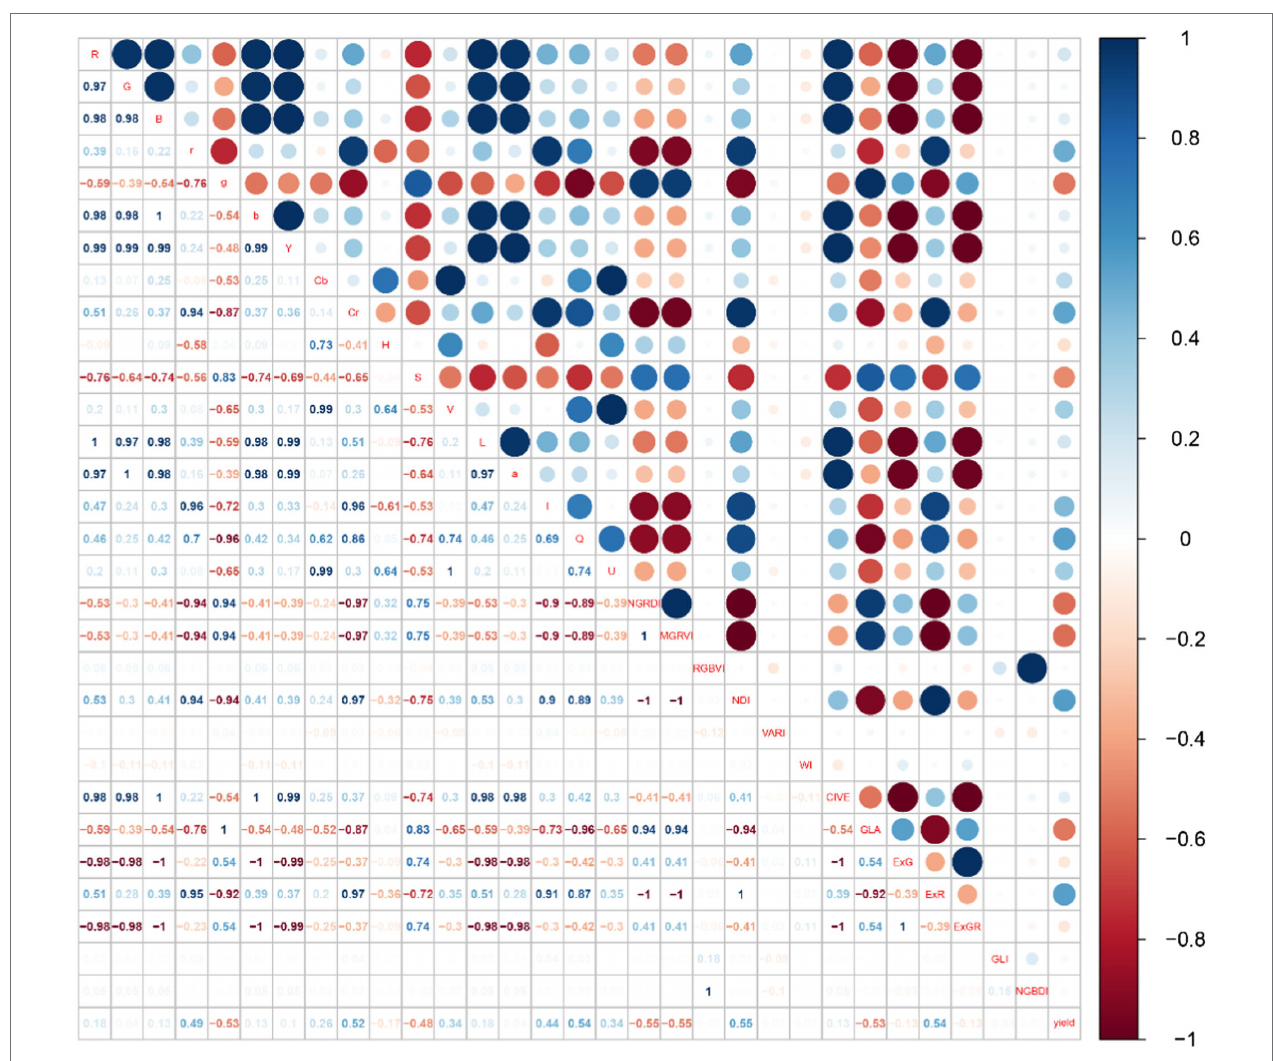
FIGURE 3 | Correlation between different vegetation indices and cotton